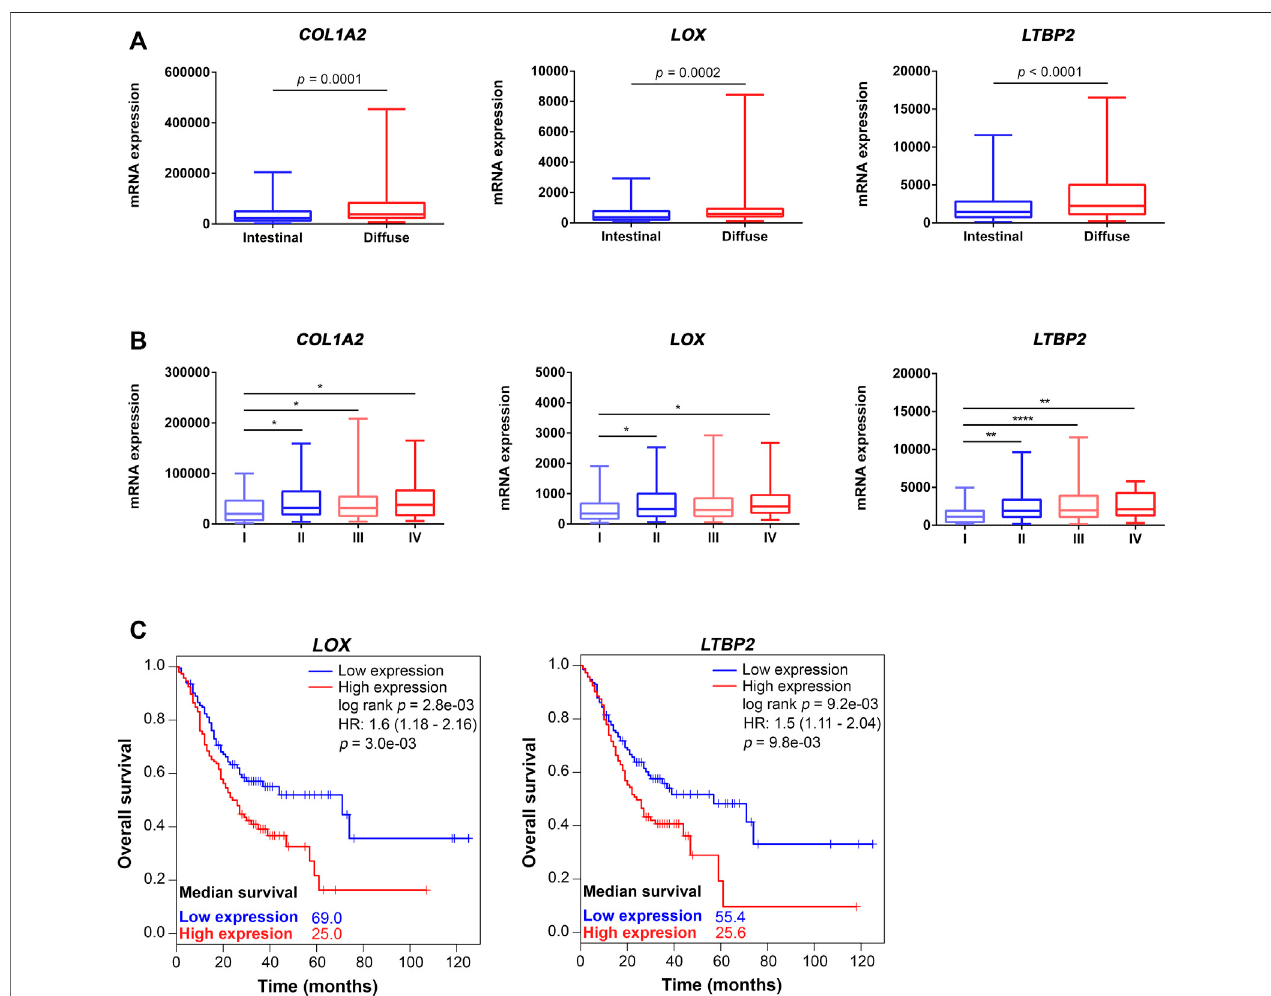
FIGURE5| AssociationofdifferentiallyexpressedECMcomponentswithGCpathologicalfeaturesandoverallsurvival.IncreasedexpressionofCOL1A2,LOXand LTBP2 is signi fi cantly associated with diffuse type GC (A) and with high TNM stage (B) . Gene expression levels were normalized through DESeq2